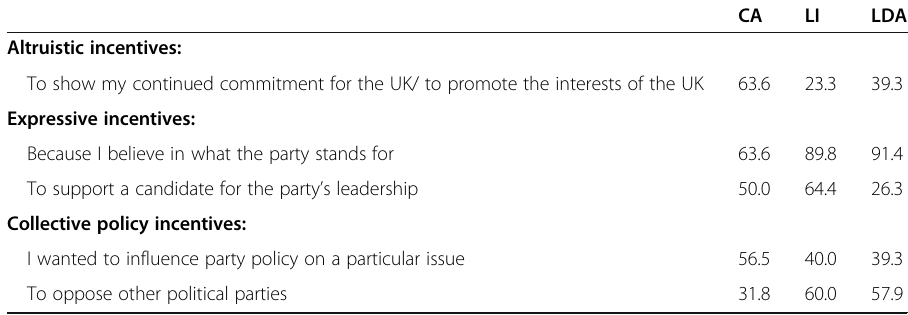
Table 2 Political and Ideological Reasons for Joining a Party Abroad (in %)